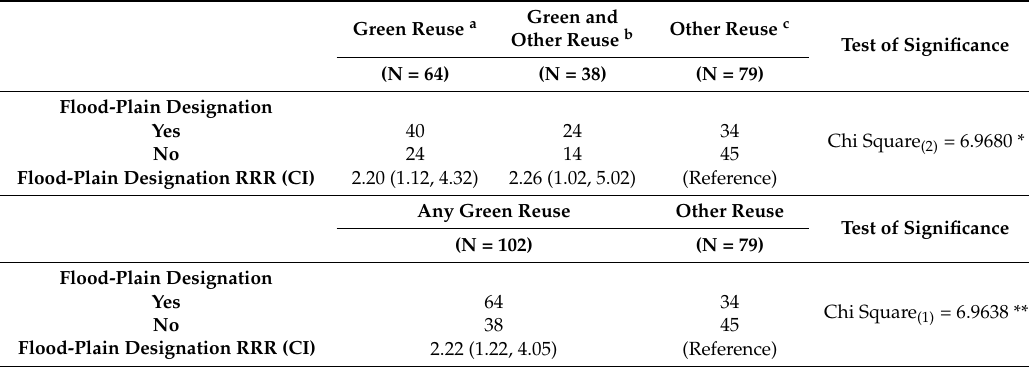
Table 4. County flood-plain designation by brownfield reuse.